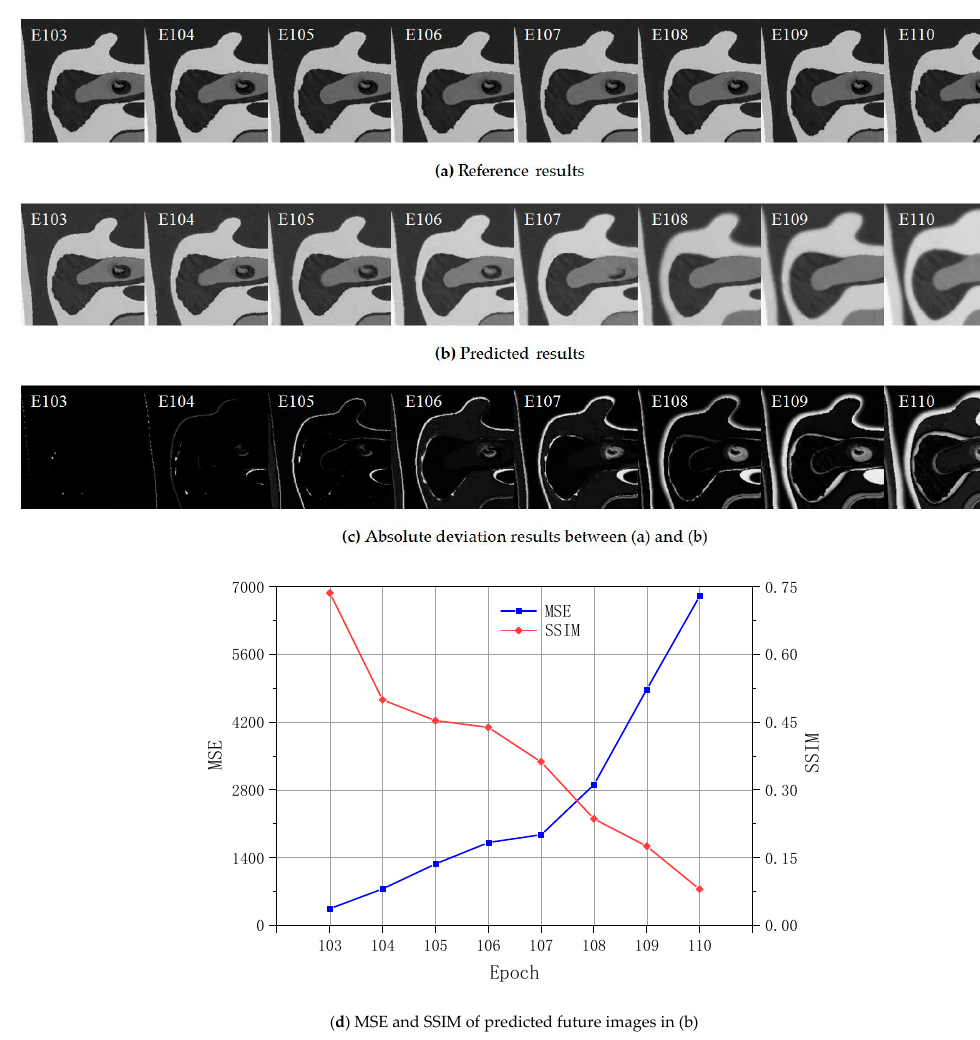
Figure 6. Comparison regarding the reference and predicted results.